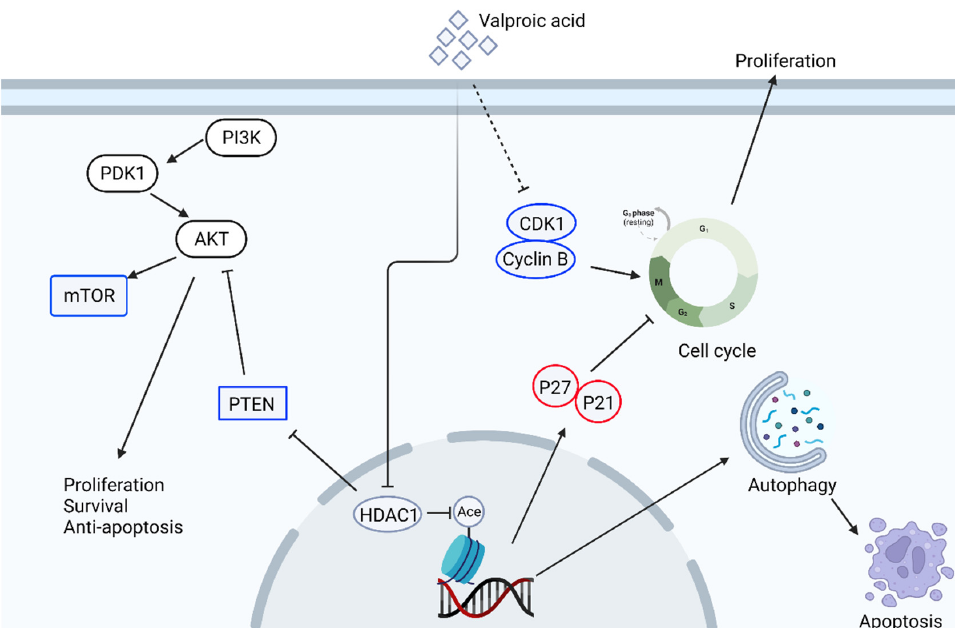
Figure 3. Schematic illustration of anti-cancer signaling pathways of valproic acid in cancer cells. The dotted line represents the proven pathway, but the mechanism is unknown. This figure is made by an online tool at BioRender.com (accessed on 15 June